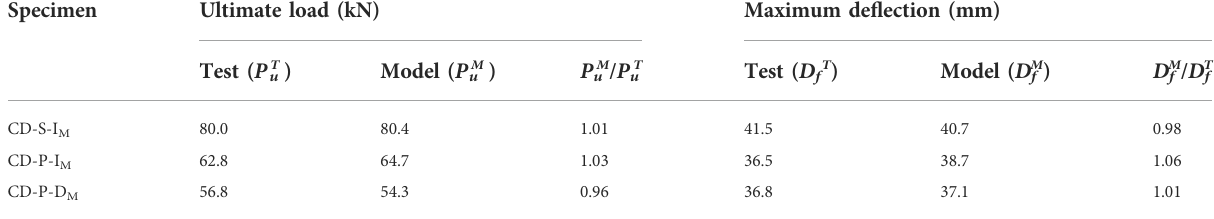
TABLE 8 Comparison of test and model